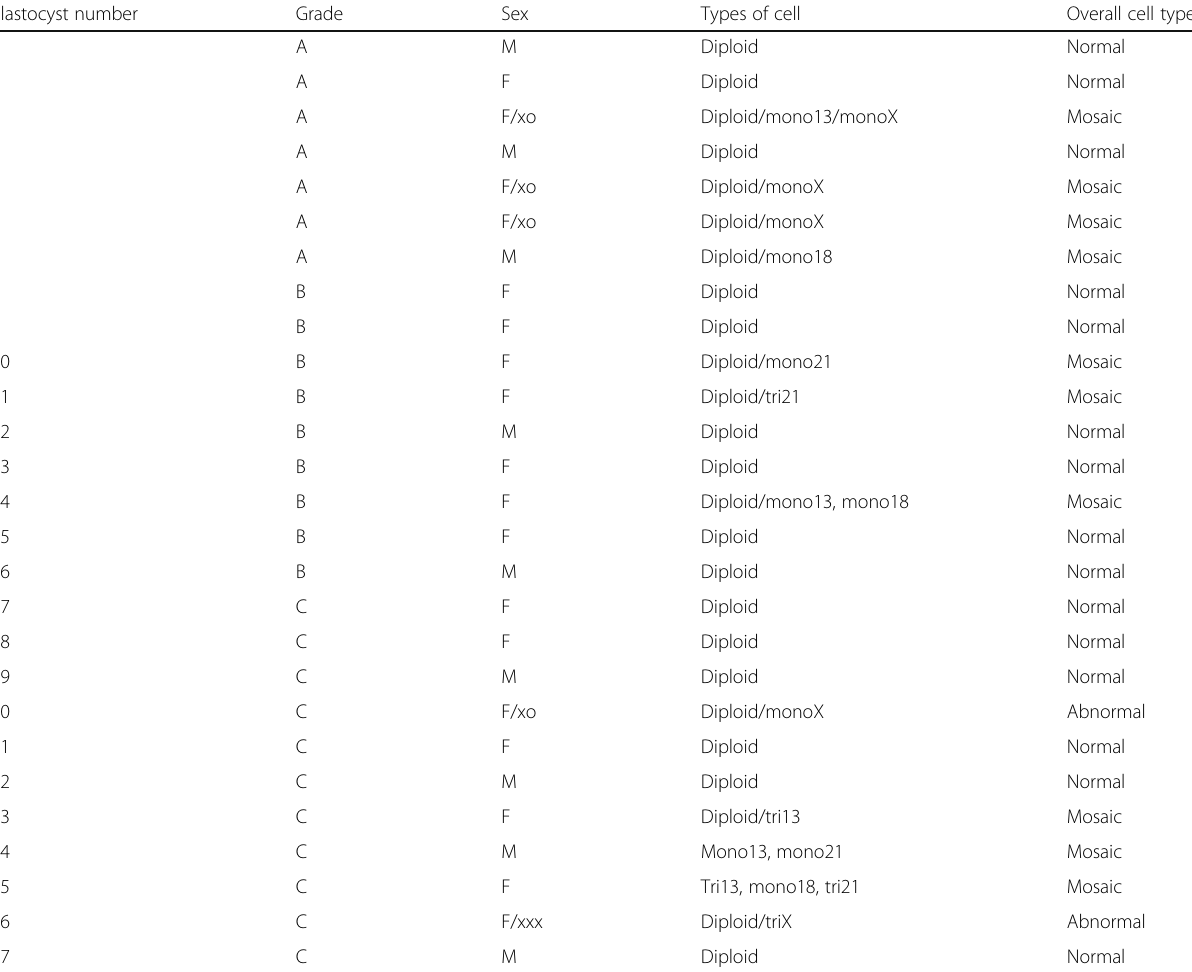
Table 2 Overview of the analyzed blastocysts based on morphological status, embryo gender, and type of cell/embryos ploidy Blastocyst